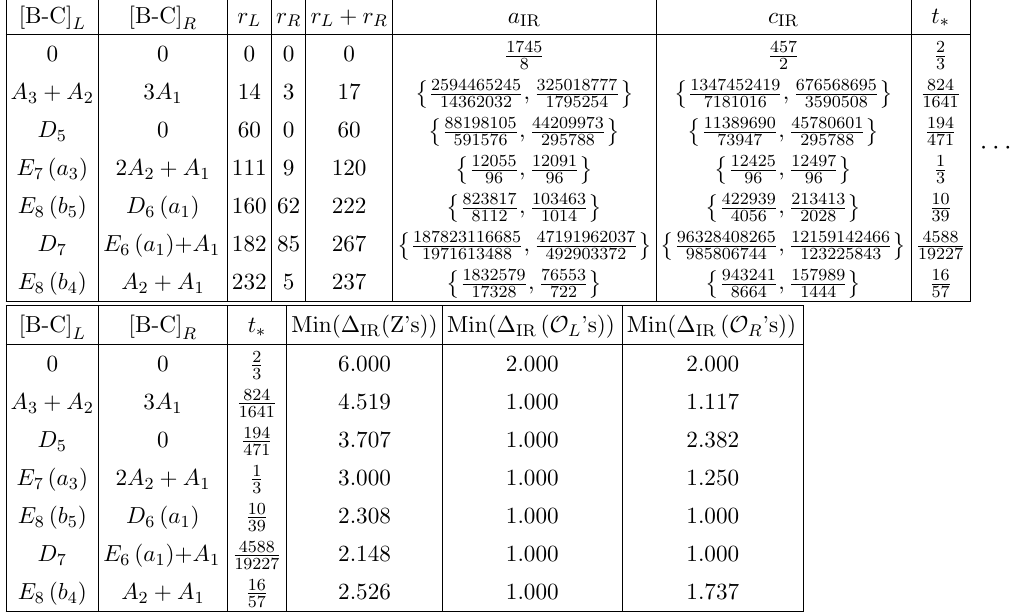
Table 19. Plain nilpotent mass deformations of ( E 8 , E 8 ) conformal matter, only rational values.